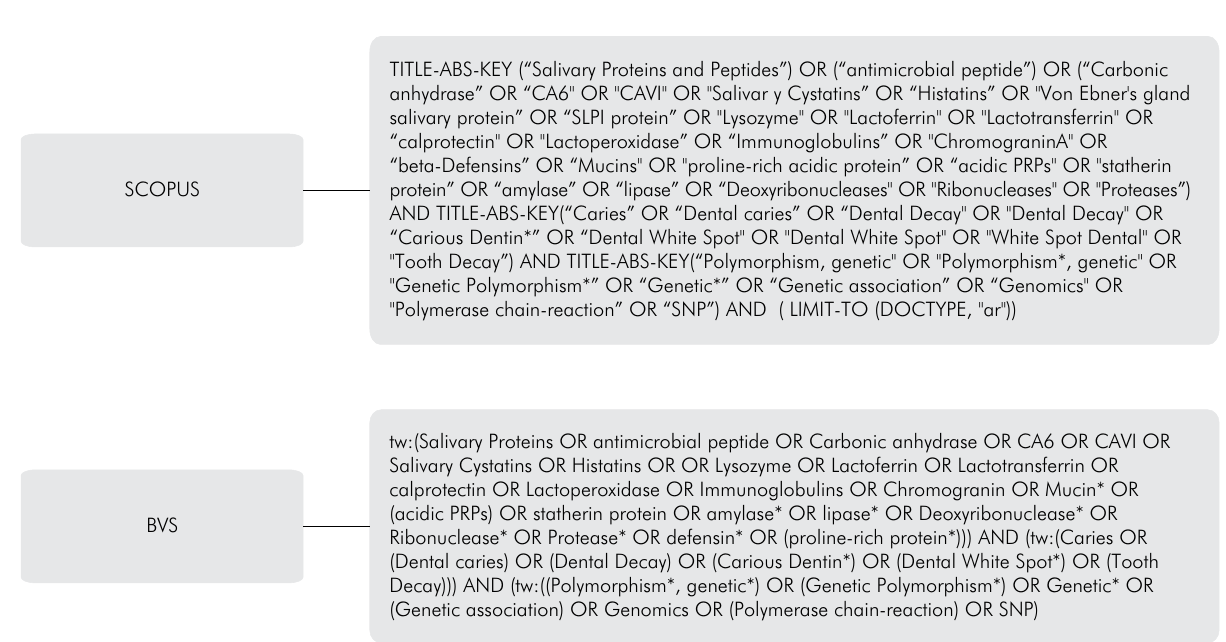
3 Braz. Oral Res.